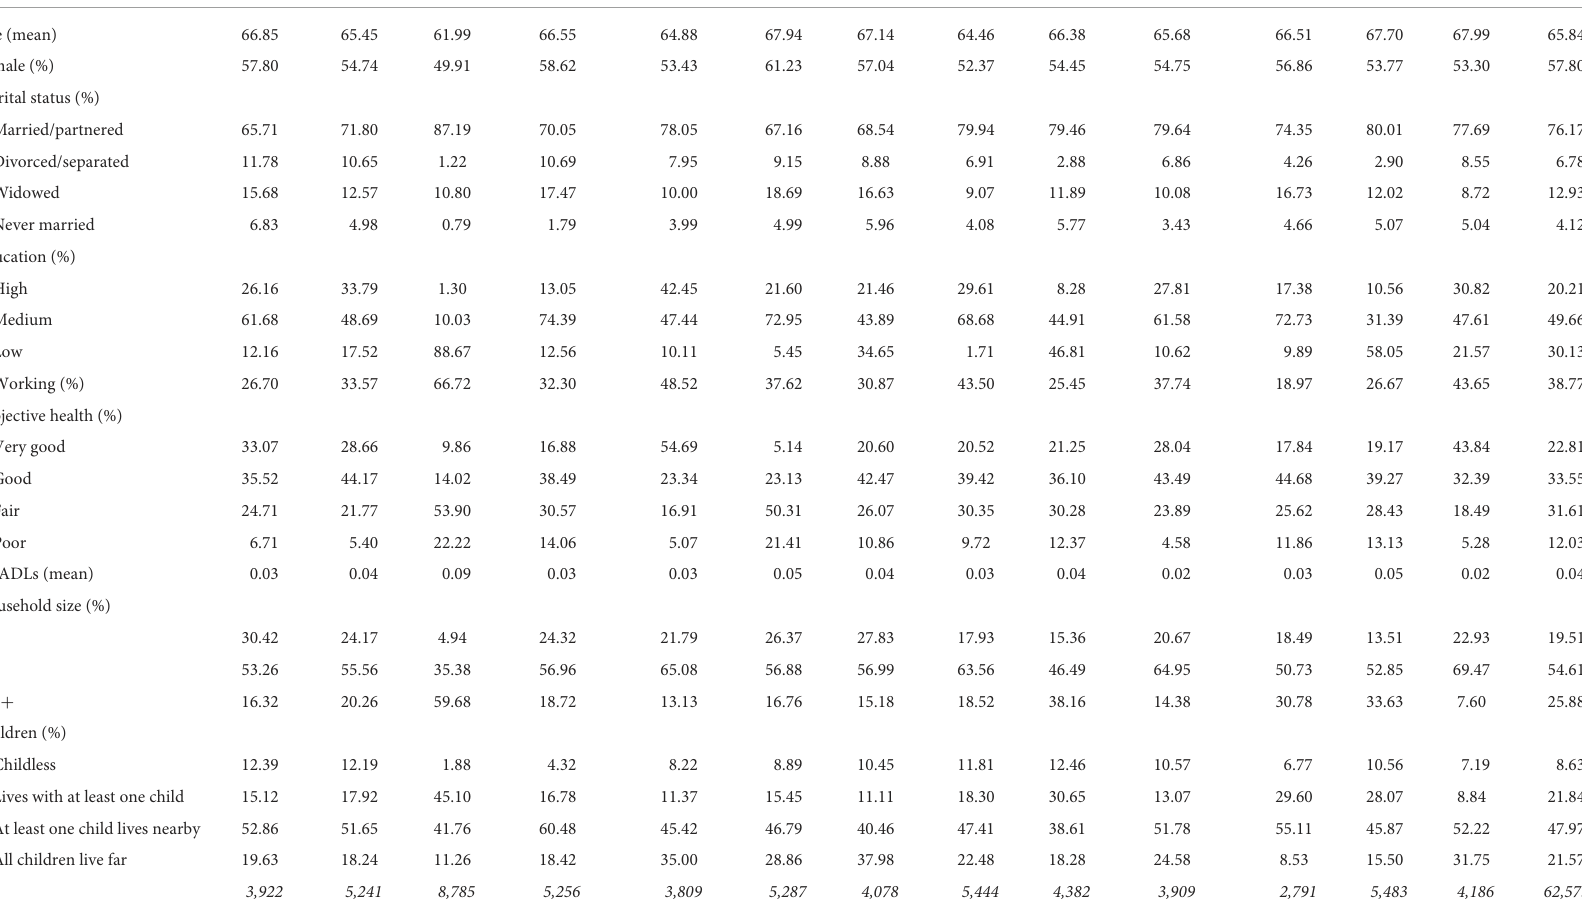
TABLE 1 Characteristics of the study